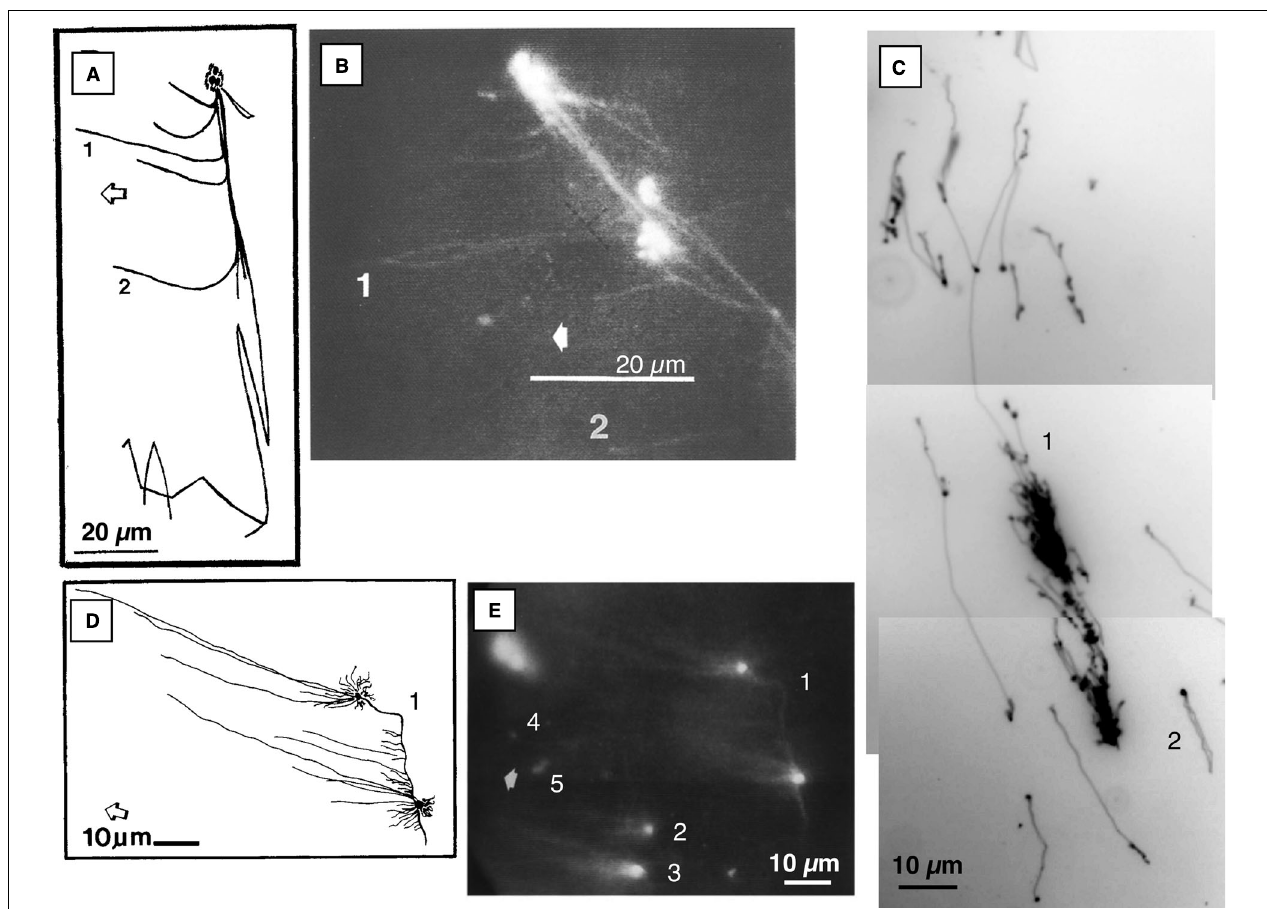
FIGURE 1 | Fluorescence microscopic images of ethidium-stained mtDNA and ptDNA molecules. (A) and (B) Images of DNA-protein structure from osmotically lysed tobacco BY-2 mitochondria. Complex branching DNA-protein structure with three bright nodes, long immobile fiber, and several fibers that extend leftward toward the anode (examples: 1 and 2) and rightward when the polarity of the electric field was reversed. (Adapted from Oldenburg and Bendich, 1998b). (C) Maize ptDNA molecules from the well-bound fraction following PFGE. Examples: (1) multigenomic complex structure with a Y-branch and (2) a genome-sized circular molecule. Approximately 84% of the DNA mass was in the large complex form, 11% in small branched molecules, and 4% in circular molecules. The in-gel ptDNA was prepared from 14-day maize seedlings. (Adapted from Oldenburg and Bendich, 2004a) (D) and (E) Images of liverwort mtDNA molecules from the well-bound fraction following PFGE. One large complex structure with two bright nodes of fluorescence that are connected by a bright fiber and several fibers extend from each node toward the anode (1). Two smaller “comet” structures with several “tail” fibers extending from the bright ”head” (2, 3). A few small molecules were moving toward the anode (examples: 4, 5). (Adapted from Oldenburg and Bendich, 1998a) The molecules in (B) and (E) were recorded using an epifluorescence microscope equipped with a CCD camera, video monitor, and recorder. Photographs were then taken of ethidium-stained DNA on the monitor and the respective drawings, (A) and (D) , were made by tracing the DNA on the monitor. The molecules in (C) were recorded using an epifluorescence microscope equipped with a digital camera and computer. Broad arrows point toward the anode in (A) , (B) , (D) , and (E)